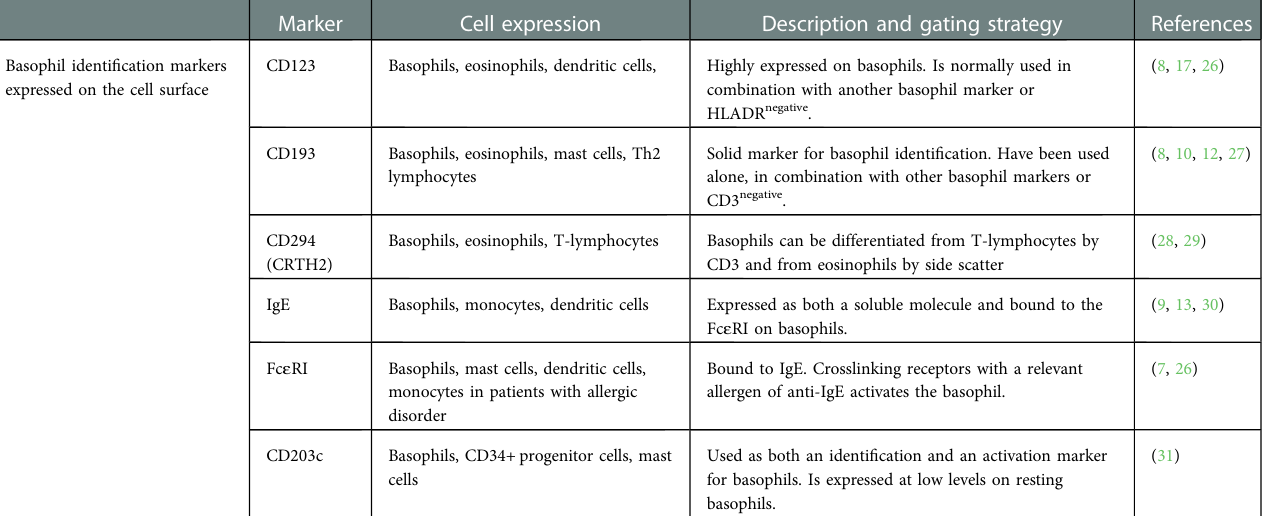
Marker Cell expression Description and gating